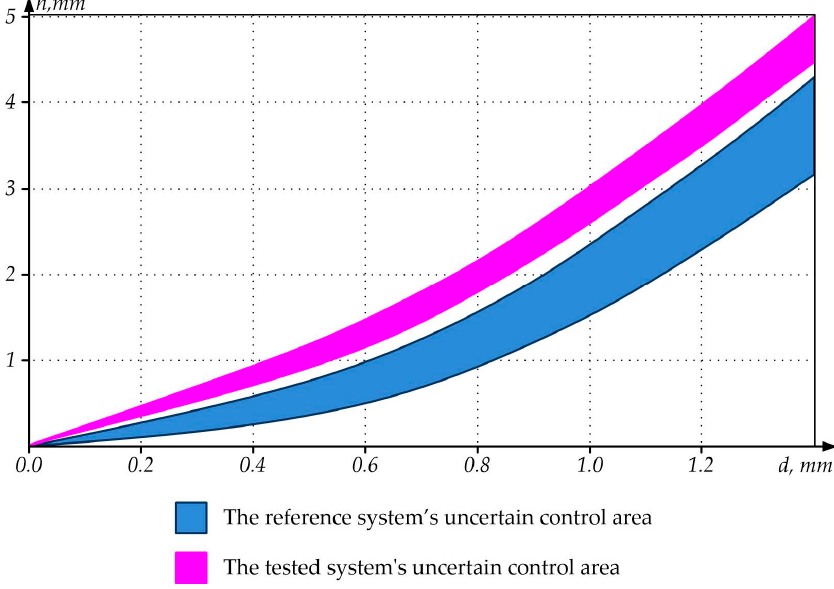
Figure 11. Flaw Detectability Areas of the Reference and Proposed Systems.